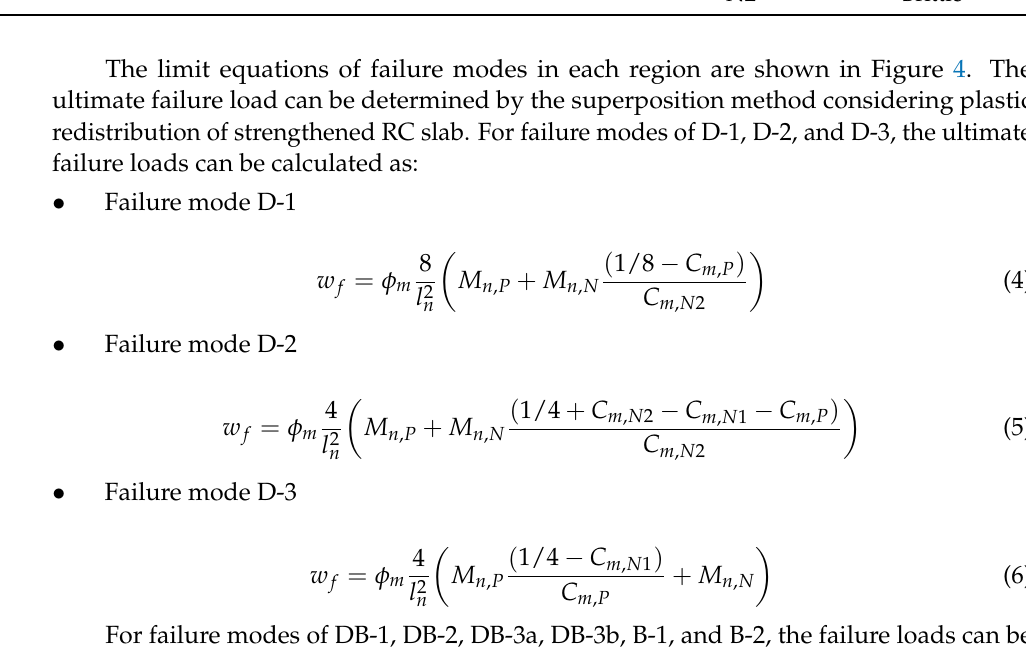
Table 1. Summary of different failure modes for the end span of an RC slab.